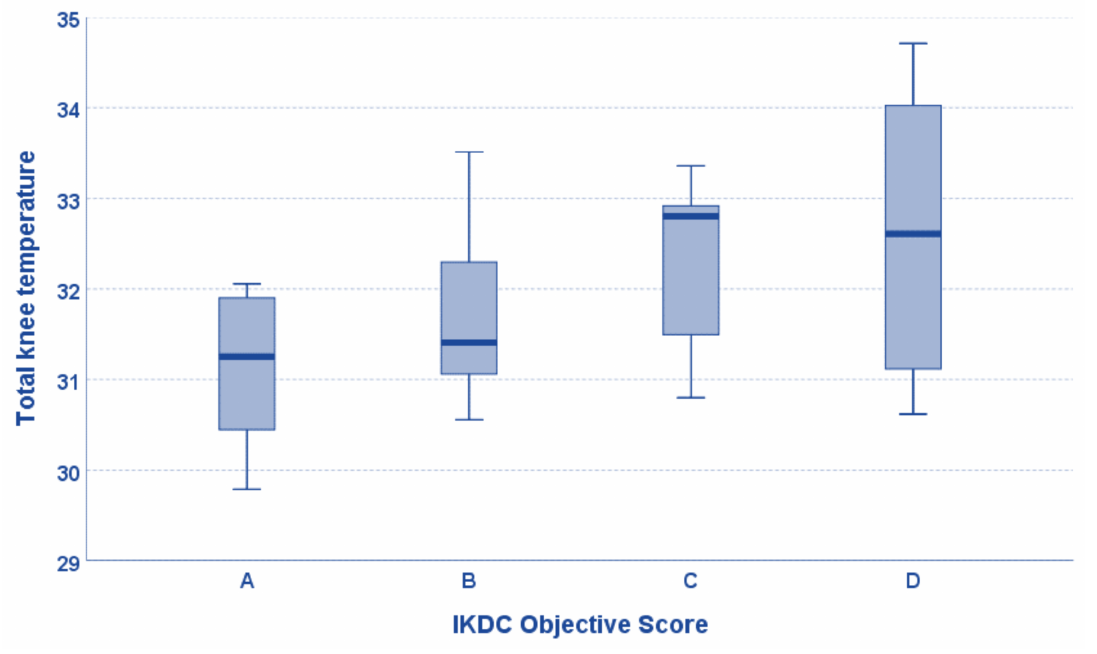
Figure 2. The mean temperature of the total knee positively correlated with the International Knee Documentation Committee (IKDC) objective score (tau = 0.294, p = 0.016). Box-and-whisker plots show median values and interquartile ranges.